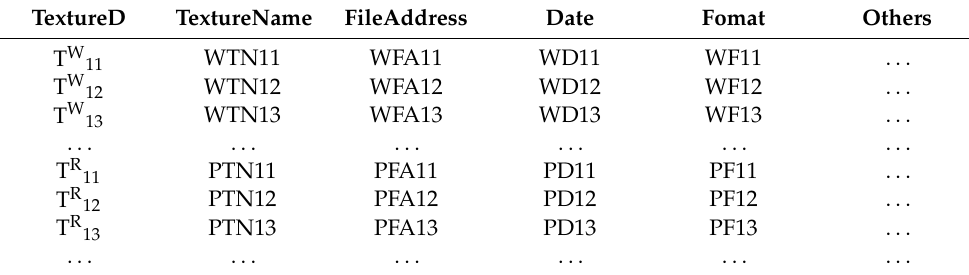
Table 10. Data texture